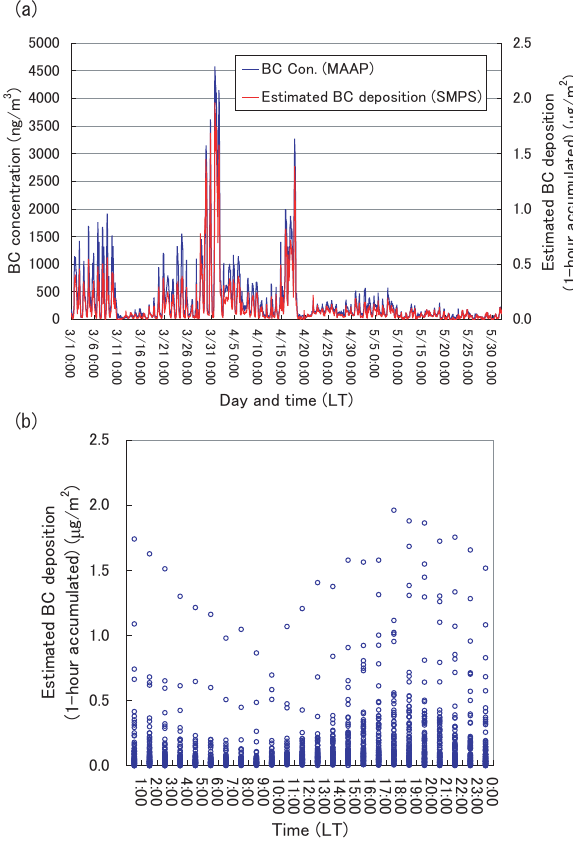
Fig. 3. (a) One-hour mean eqBCC from MAAP data (Bonasoni et al., 2008) and estimated hourly total BCD flux (right side scale) as multiplying dry deposition amount from SMPS data by 0.087 during March–May in 2006; (b) Composite of the estimated hourly total BCD flux during March–May in